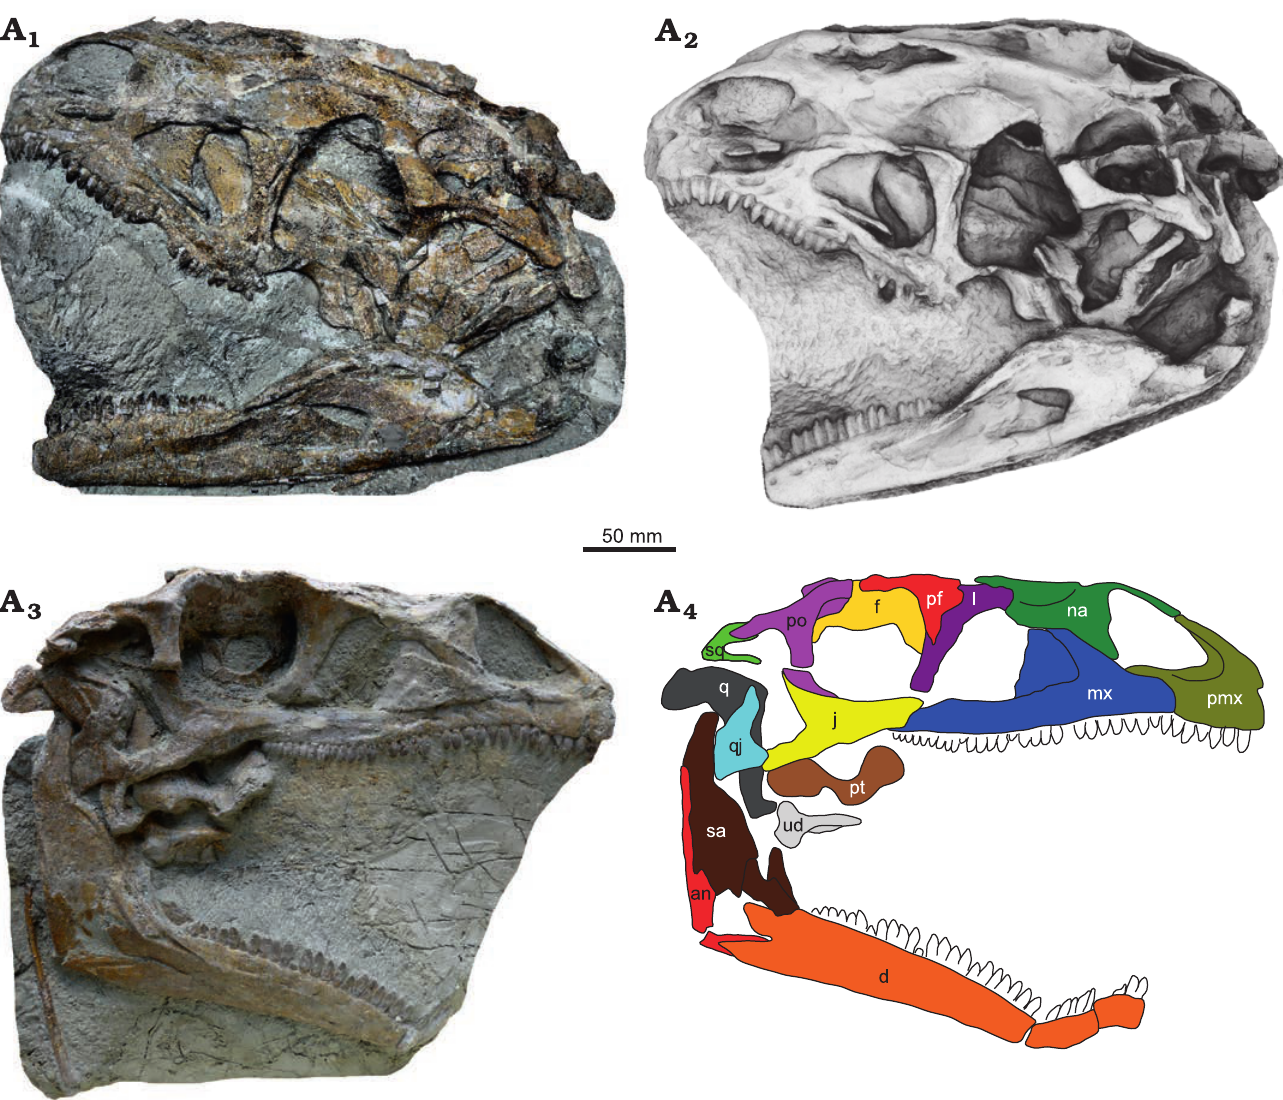
Fig. 3. Skull of Plateosaurus trossingensis (MSF 16.1) from the Triassic of Frick, Switzerland. Photograph of the left side (A 1 ); ambient occlusion of the 3D-model of the left side (A 2 ); photograph of the right side (A 3 ) and interpretative diagram (A 4 ). Abbreviations: an, angular; d, dentary; f, frontal; j, jugal; l, lacrimal; mx, maxilla; na, nasal; pf, prefrontal; pmx, premaxilla; po, postorbital; pt, pterygoid; q, quadrate; qj, quadratojugal; sa, surangular; sq, squamosal; ud,